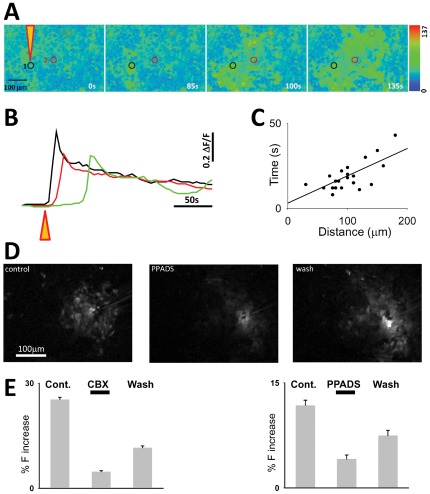
Calcium wave propagation in astrocytic networks.
A. Images showing a field in a pure NT2 astrocyte culture loaded with Fluo-4. Following image at t = 0 s, a mechanical stimulation was applied at point indicated by orange triangle tip. Subsequent images display the progression of a calcium wave in surrounding astrocytes. B. The time course of fluorescence in the circled astrocytes at different distances from the origin. C. Plot of wave distance with time for a number of experiments fitted with a linear regression. D. Maximum projection images showing extent of wave propagation in control, with PPADS and following PPADS wash off. E. Bargraphs summarising a number of experiments where fluorescence was measured in astrocytes during wave propagation, and the effect of CBX and PPADS. Cells were used within 14 days of differentiation.